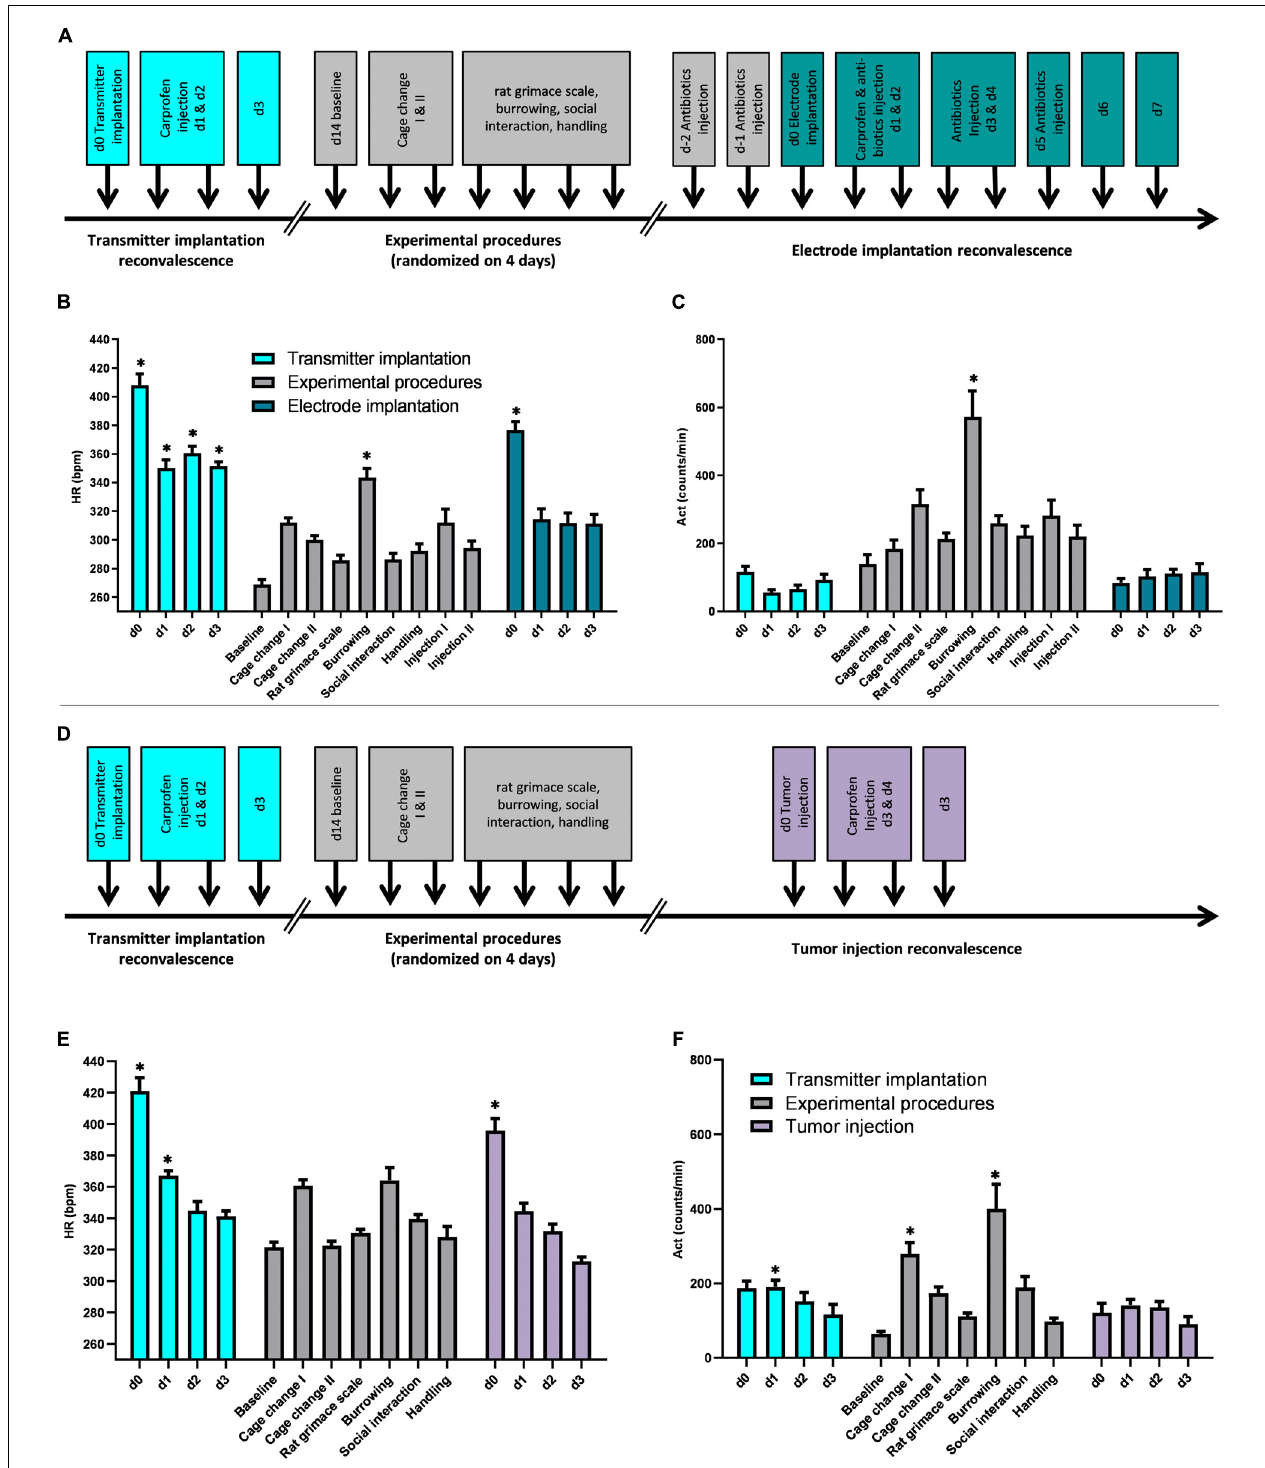
FIGURE 1 | Telemetric HR and Act data. Timeline of experimental setup, mean heart rate (HR; bpm), and summed activity (Act; counts/min) for 4 h after indicated procedures of SD rats (A–C) and BDIX rats (D–F) . Data showed increased HR after surgery without increased Act and increased HR and Act after some experimental procedures. Colors indicate different procedures (turquoise—transmitter implantation, gray—experimental procedures, dark green—electrode implantation, purple—tumor injection). Significant differences are indicated by asterisk (*Friedman test, followed by Dunn’s multiple comparisons post hoc test against baseline; P < 0.05). Data are shown as mean +